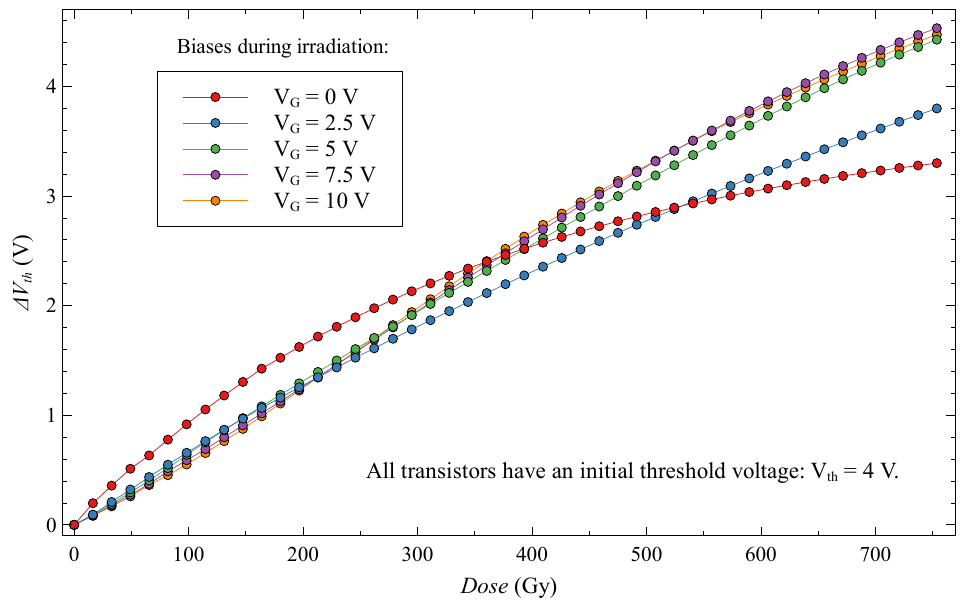
Figure 17. Threshold voltage shift for EPADs with static bias during